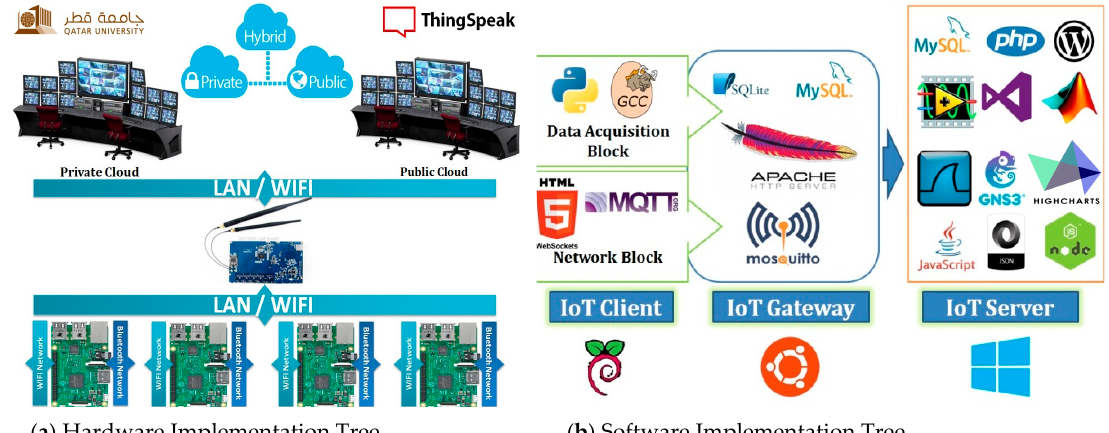
Figure 10. Case Study: QU SHM Sites Deployment Details ( a , b ).